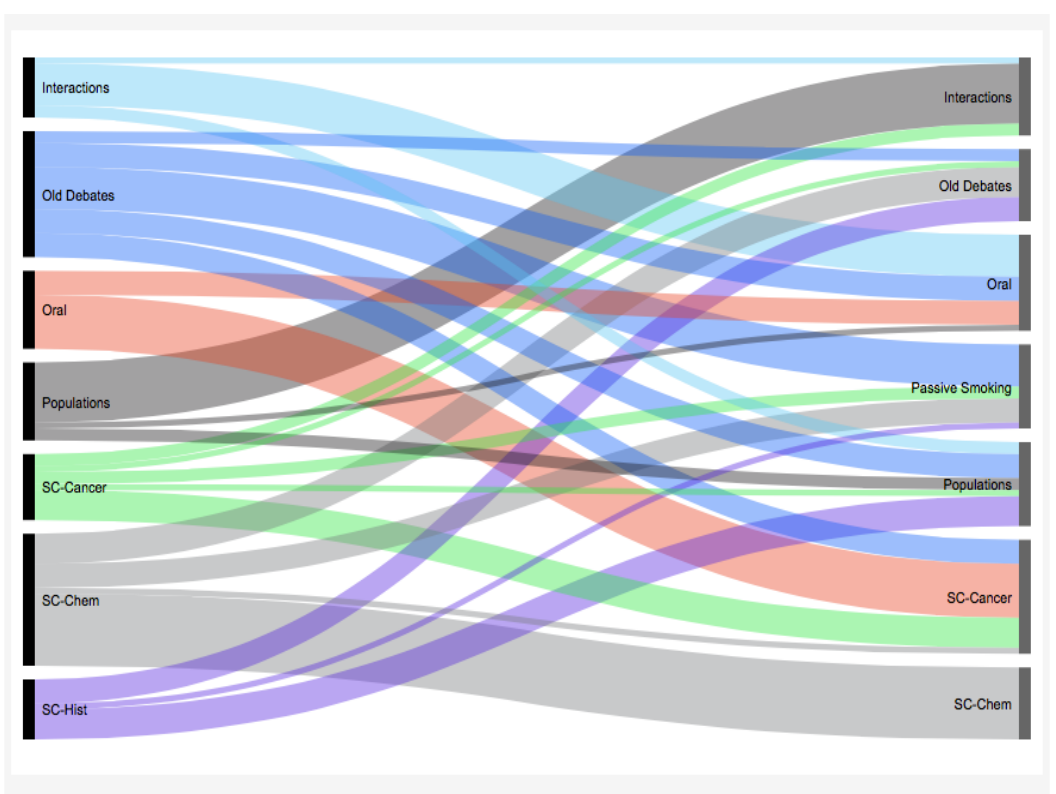
Figure 5: Community shifts in 1979–1985. One hundred papers that are present in both networks from Figure 4 for 1979 and 1983 are plotted by their community in 1979 (left-hand side) and their community in 1983 (right-hand side).